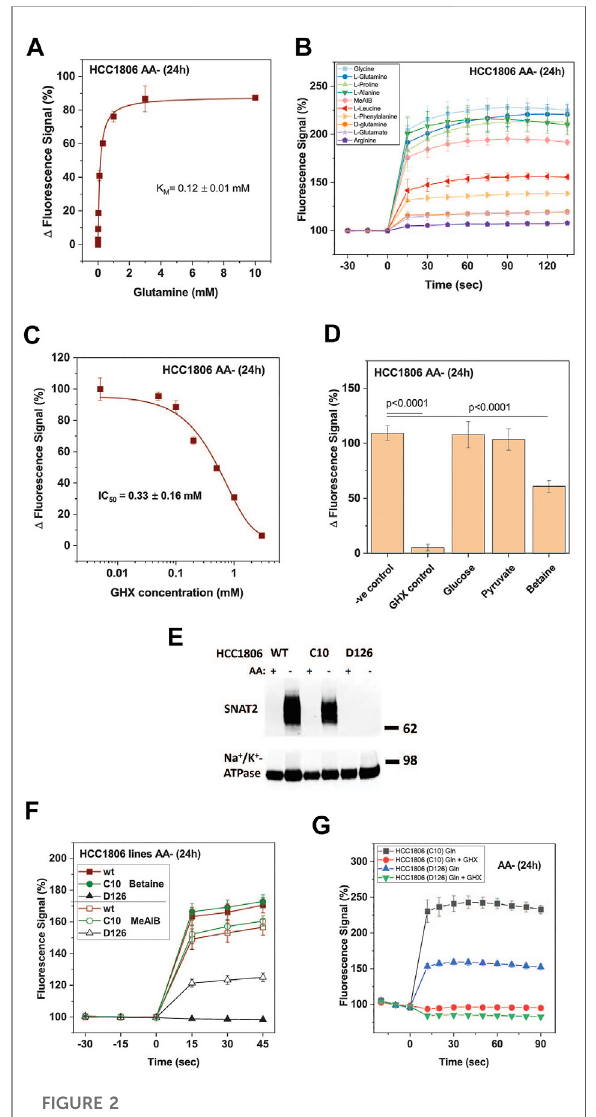
FIGURE 2 Optimization of HTS conditions to identify SNAT1 and 2 inhibitors. HCC1806 cells were incubated in glucose- supplemented Hanks ’ s buffered salt solution (mHBSS) for 24 h to induce amino acid transporter expression. (A) The FMP assay was used to determine kinetic parameters of glutamine transport. The plateau of the FMP signal was plotted against the glutamine concentration (n = 3). (B) Time course of the FMP signal for different amino acids at a fi nal concentration of 1 mM (n = 3). (C) IC 50 curve of GHX inhibition of glutamine induced membrane depolarisation using FMP assay. Data are plotted as mean ± STD (n = 3) percentage change between post-injection and baseline fl uorescence measurements. (D) Starved HCC1806 cells were assayed on a 384-well plate using two non-inhibitors of SNAT2, glucose and pyruvate, and two low-af fi nity substrates, betaine and pyruvate (all at 10 mM). Depolarisation was elicited with 1 mM glutamine. Negative ( − ve) control corresponds to pre-incubation of cells in FMP dye and plain mHBSS. The values shown correspond to the signal change after the injection of glutamine, expressed as a percentage of the baseline reading (n = 19). (E) Western blot of surface biotinylated protein detecting SNAT2 in HCC1806 C10 cells (ASCT2ko) and D126 (ASCT2ko, SNAT2 ko) cells starved of amino acids for 0 h (AA+) and 24 h (AA-). The Na +